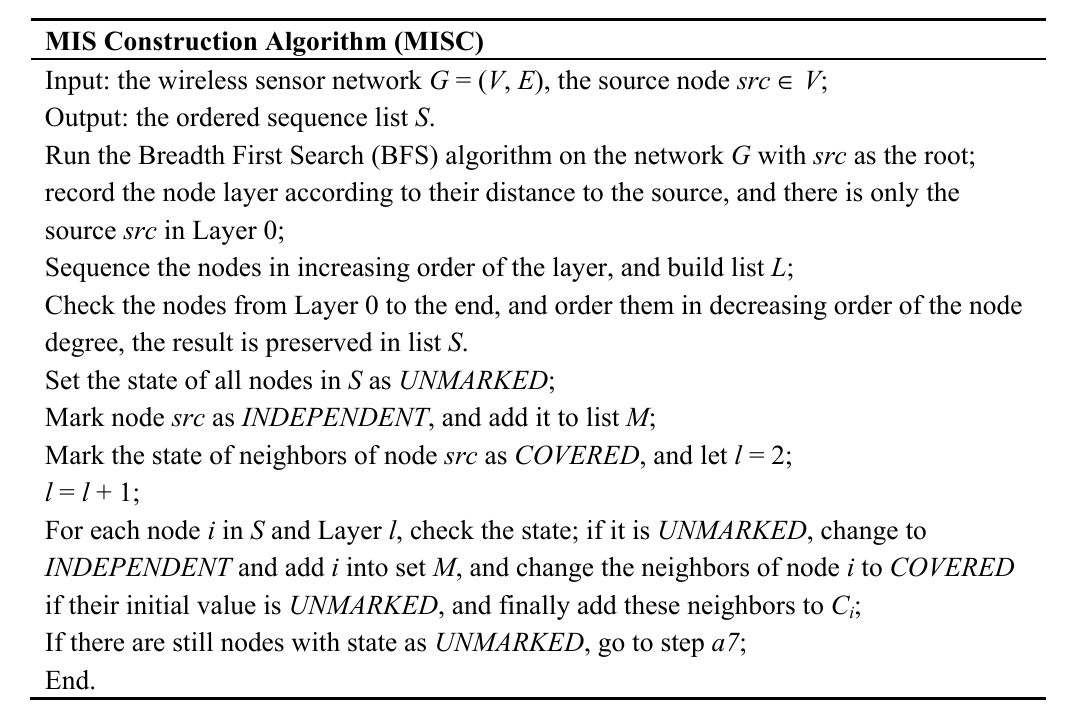
Algorithm 1. MIS Construction Algorithm